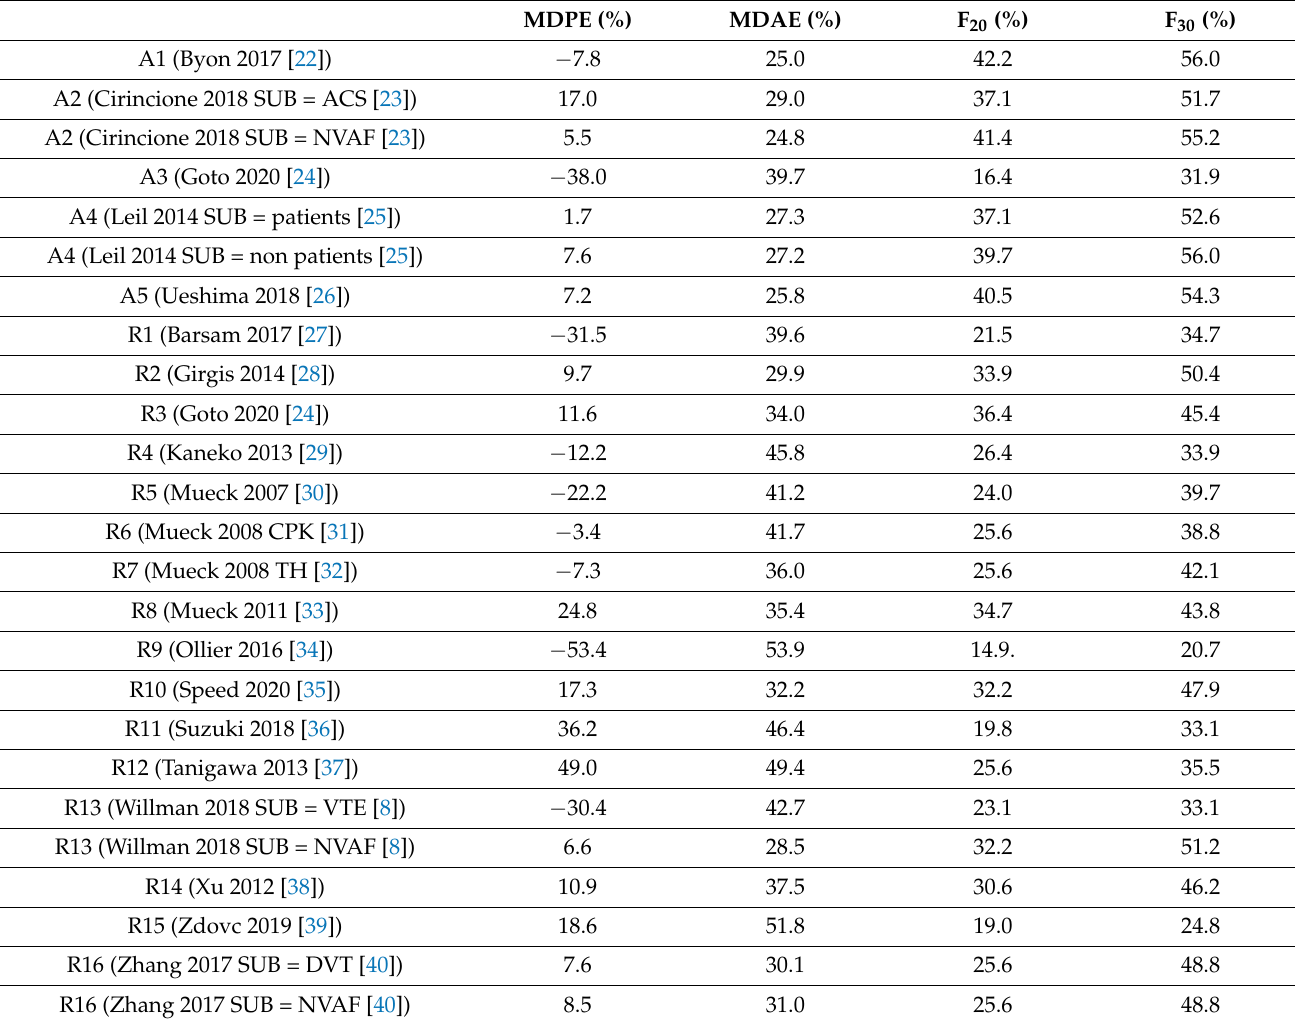
Table 3. Bias and imprecision of the published of the published population pharmacokinetic models applied to the EVD.